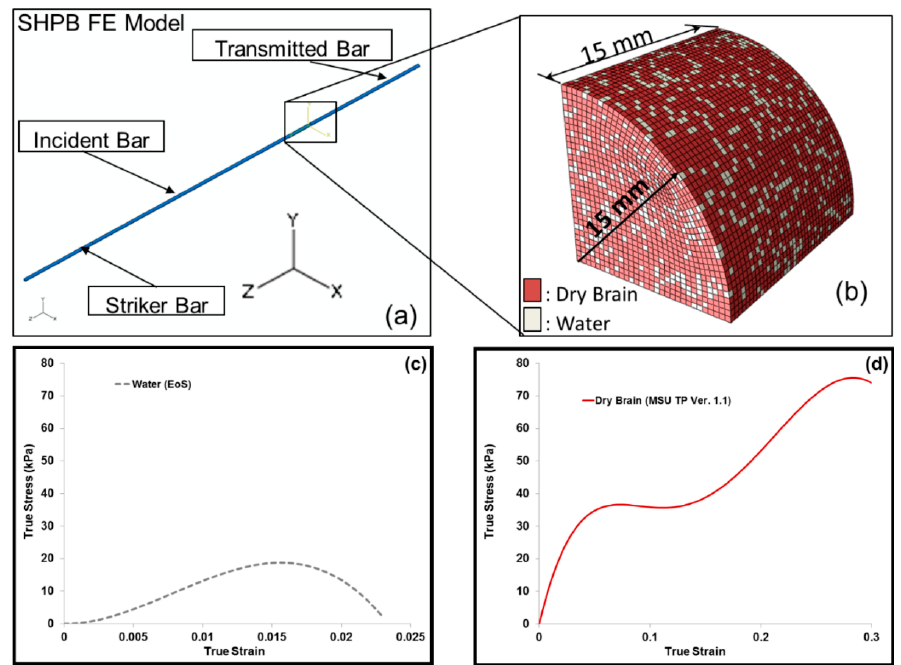
Figure 5. ( a ) A schematic of the finite element (FE) set up for Split-Hopkinson pressure bar (SHPB) tests and ( b ) FE simulation sample dimensions, with a sample having 20% (m/m) water and 80% (m/m) dry brain. The water content in the dry brain is ~0% (m/m). Local loading direction (negative z-direction) true stress–strain responses of ( c ) water and ( d ) dry brain. Mixture theory was applied to obtain the entire sample’s mechanical response. Table 2. Overview of the finite element (FE) simulation cases for the micromechanics of dry brain and water content variation FE Simulation Case